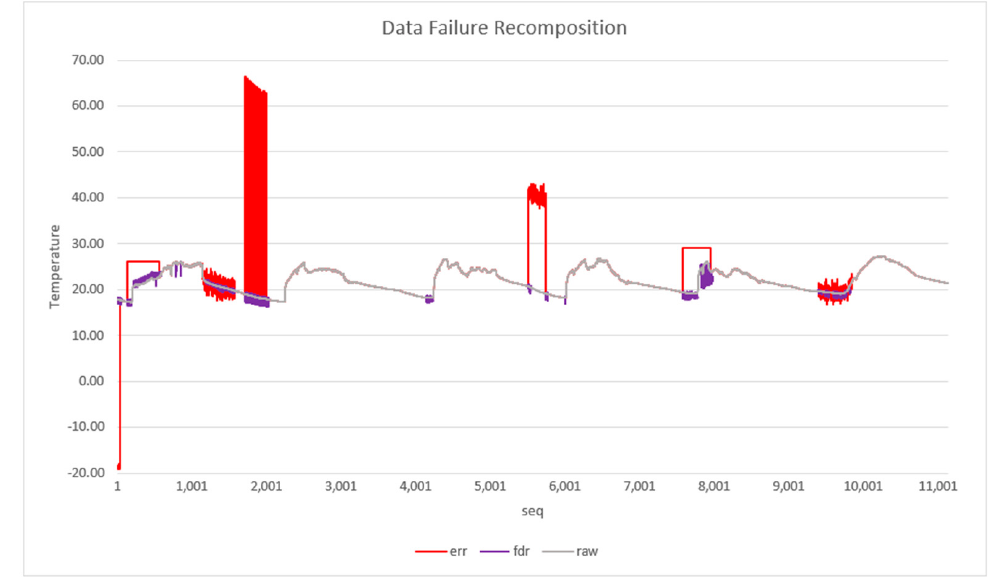
Figure 11. Failure Data Recomposition.